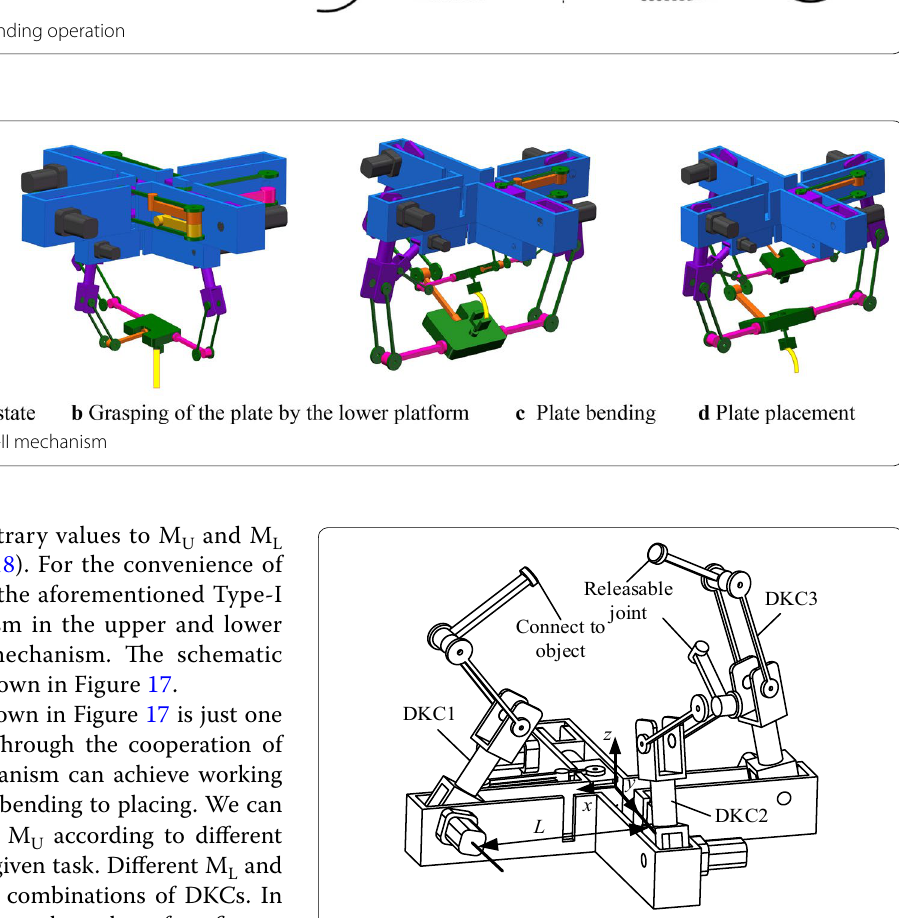
Figure 18 Three DKCs are in extension